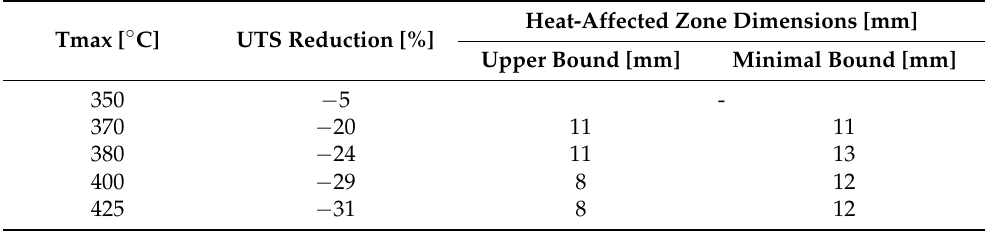
Table 5. Material softening degree and heat-affected zone dimension upper and minimal values to meet a successfully produced component at a punch displacement of 30